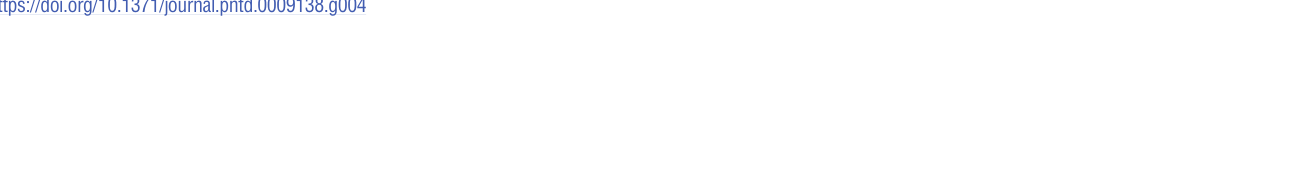
PLOS NeglectedTropical Diseases | https://doi.org/10.1371/journal.pntd.0009138 February 18, 2021 15 /